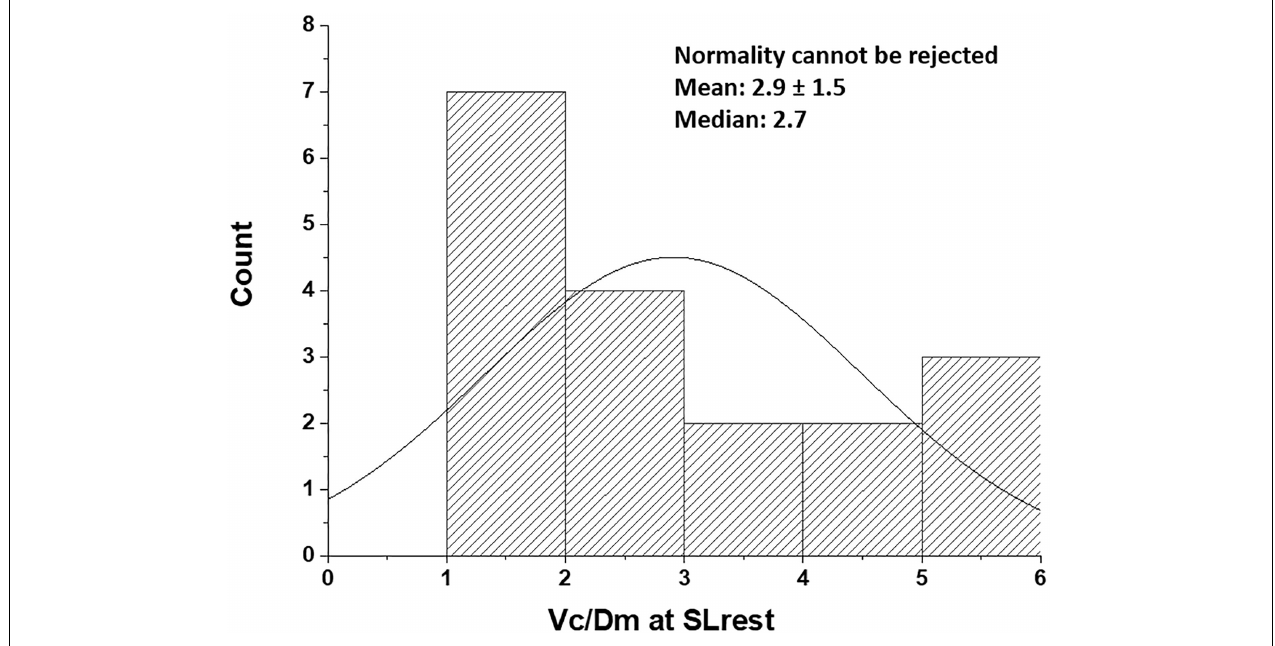
FIGURE 3 | Distribution of Vc/Dm in the population studied at the sea level rest at 100% TLC [data from Bartesaghi et al. (2014)]. Values are expressed as ml/(ml · min − 1 · mmHg − 1 ).